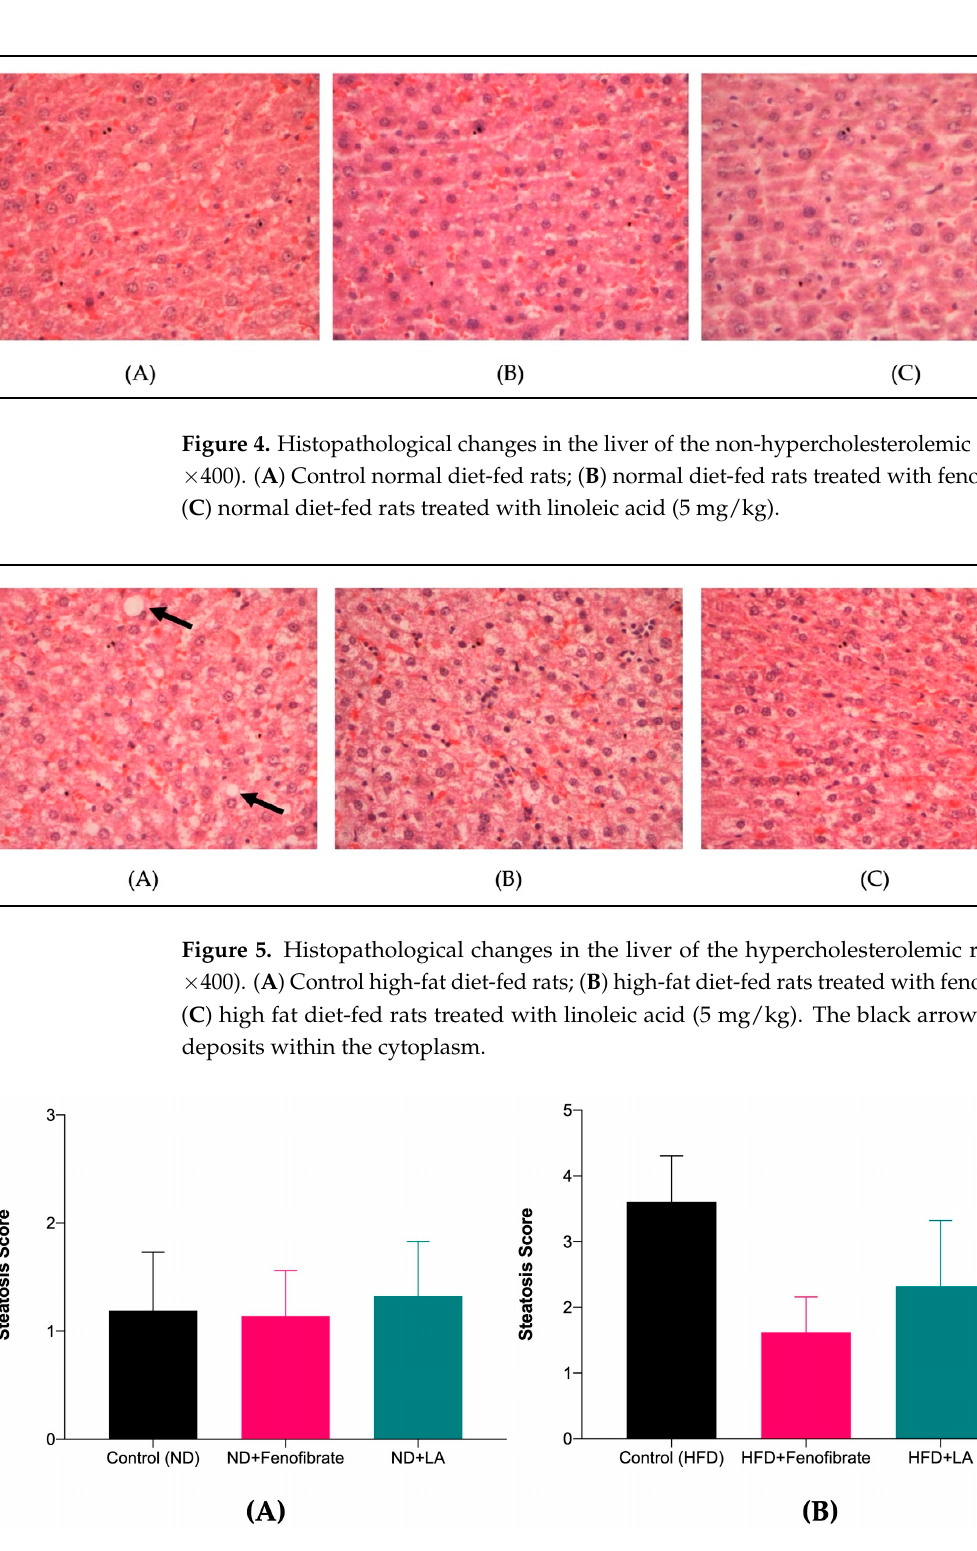
Figure 6. Steatosis scoring of liver tissue of rats fed with a normal diet ( A ) and a high-fat diet ( B ), treated with fenofibrate (60 mg/kg) and linoleic acid (5 mg/kg) for 28 days. Data are presented as mean ± SD ( n = 6). Normal diet: ND; high-fat diet: HFD; linoleic acid: LA.